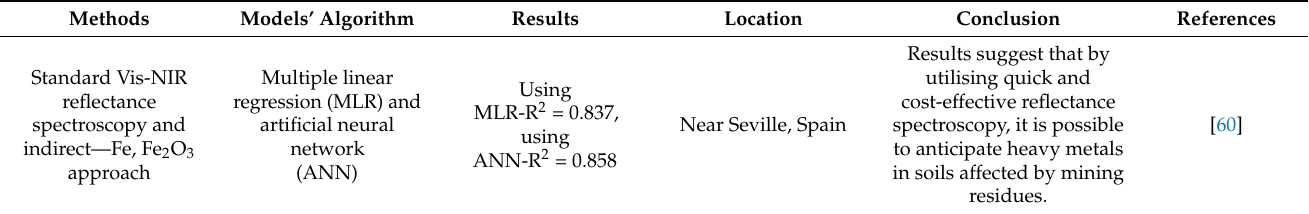
Figure 4. The spectral reflectance of the soil As contaminant samples, ( a ) Savitzky–Golay (SG), ( b ) first derivation (FD), ( c ) second derivation (SD), and ( d ) multiplicative scatter correction (MSC). (Each curve depicts the spectral profile of a single soil sample) (adapted from Han et al., 2020 [100]). Table 3. Review of hyperspectral reflectance approach in soil As contamination.